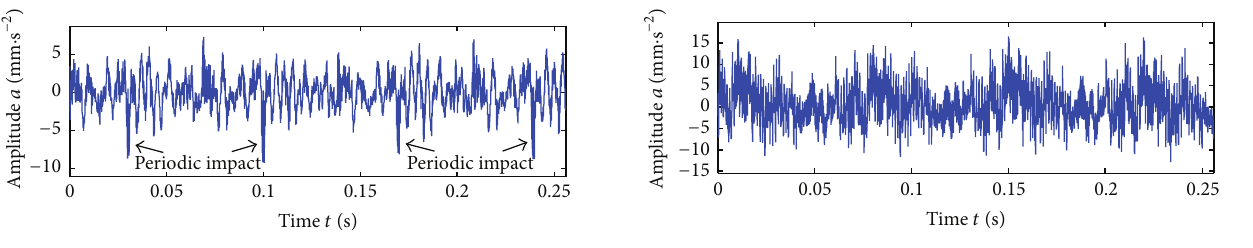
Figure 4: The time series vibrational signal of normal valve. Figure 5: The time series vibrational signal of abnormal valve.